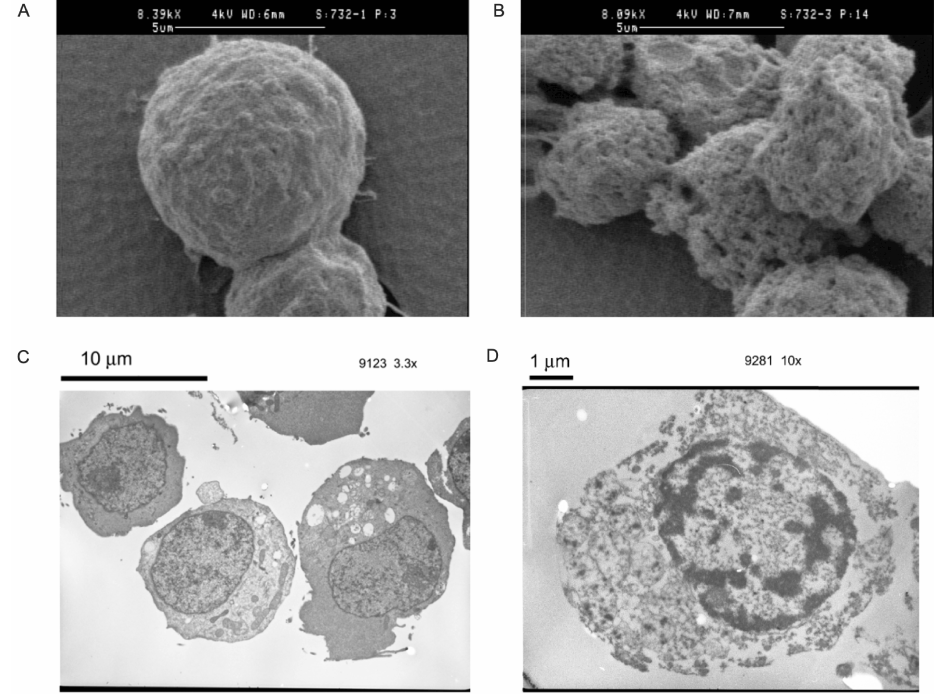
Figure 5. SEM images of Jurkat cells including a ( A ) Live cell and a ( B ) Dead (4 mM H 2 O 2 -treated) cell (scale bar: 5 µ m). TEM images of Jurkat cells ( C ) Live cell (scale bar: 10 µ m), ( D ) Dead (4 mM H 2 O 2 -treated) cell (scale bar: 1 µ